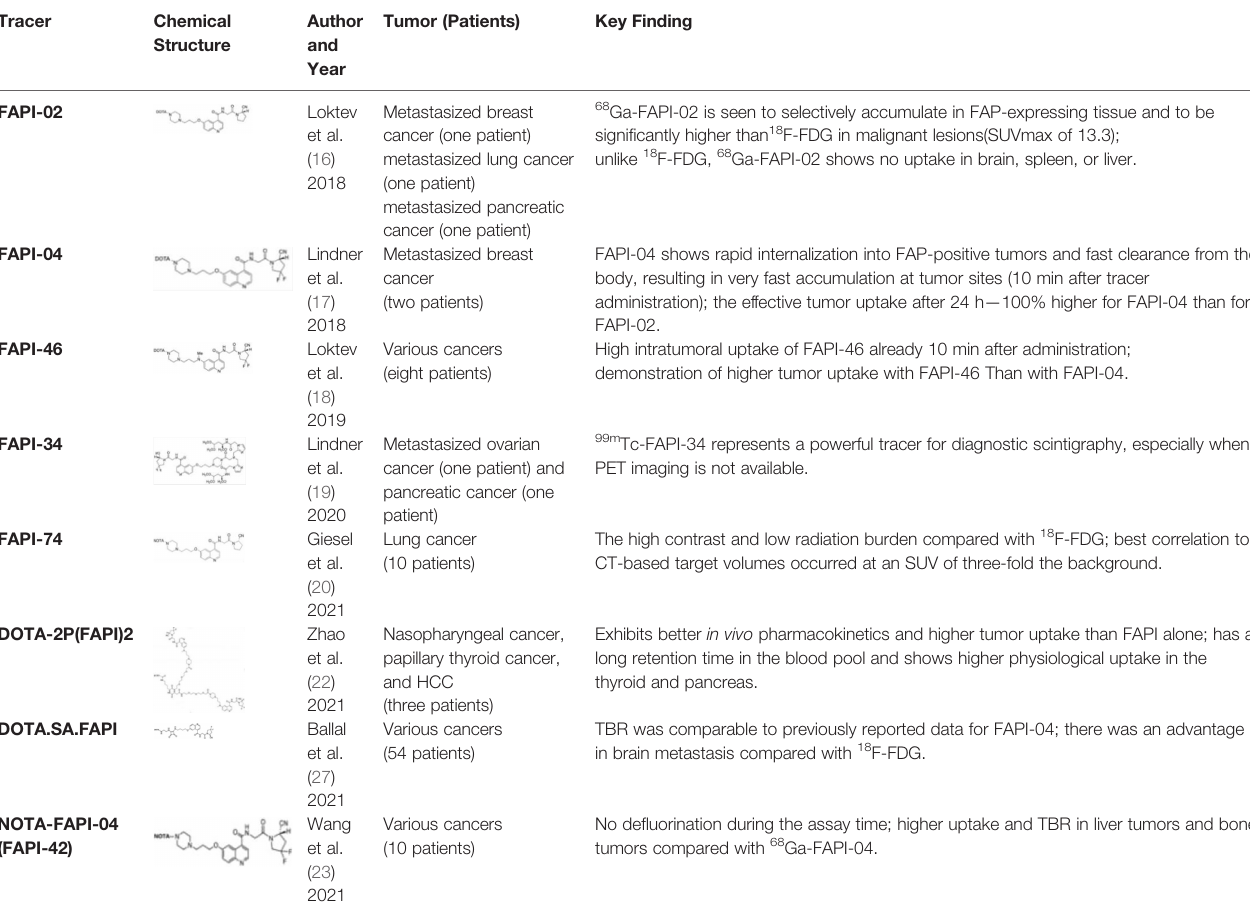
TABLE 1 | FAPIs that have been used in clinical